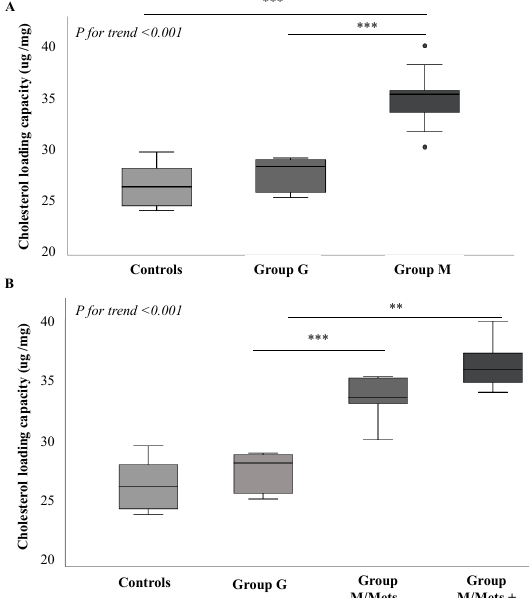
Figure 5. Comparison of plasma cholesterol loading capacity between study groups. ( A ) shows CLC according to NAFLD classification. *** p < 0.0001; ( B ) shows CLC according to MetS status. *** p < 0.0001; ** p = 0.003. Each bar represents the median and IQR cholesterol content of cells exposed to patient plasma. Group M, metabolic NAFLD group; Group G, genetic NAFLD group; Group M / MetS − , metabolic NAFLD group without MetS diagnosis; Group M / Mets + , metabolic NAFLD group with MetS diagnosis (see Section